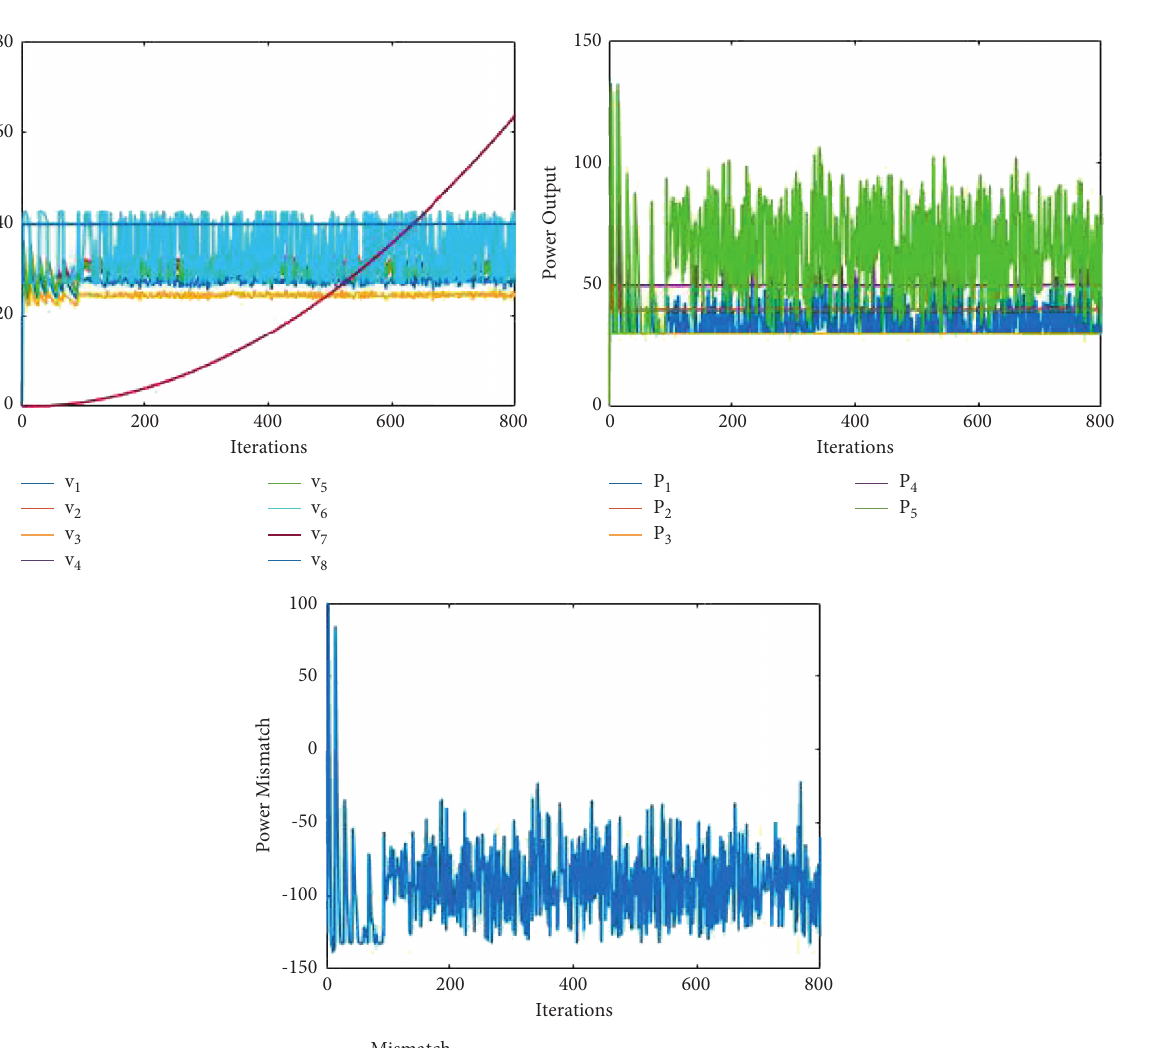
Figure 4: Variables of distributed energy management under FDIAs: (a) dual variables, (b) power output, and (c) power mismatch.